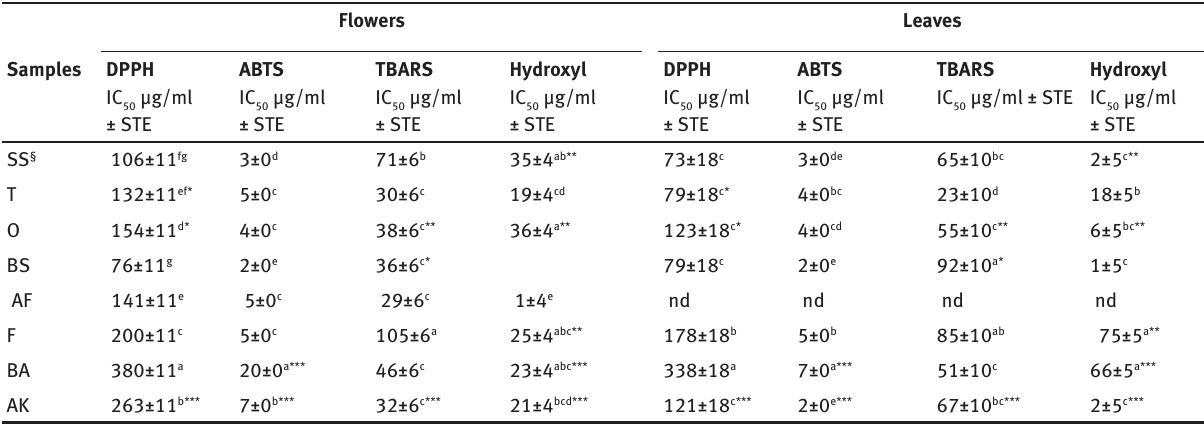
Table 3 : Antioxidant activity of essential oils isolated from flowers and leaves of A. pusilla collected at different places of Algeria. Flowers